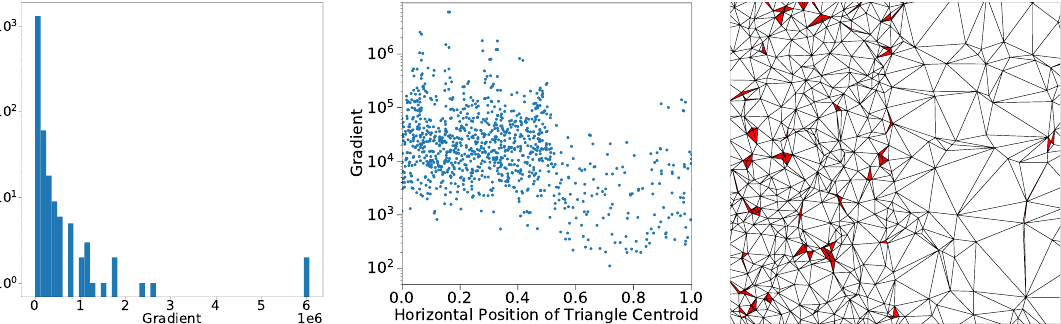
Figure 6 . Left panel: distribution of the magnitudes G α of the gradient vectors ~G α computed in the process of triangulation wombling. Middle panel: a scatter plot of G α versus the horizontal position of the centroid of the corresponding Delaunay triangle D α . Right panel: the Delaunay triangles (red-shaded) within the top 10 th percentile as ranked by gradient